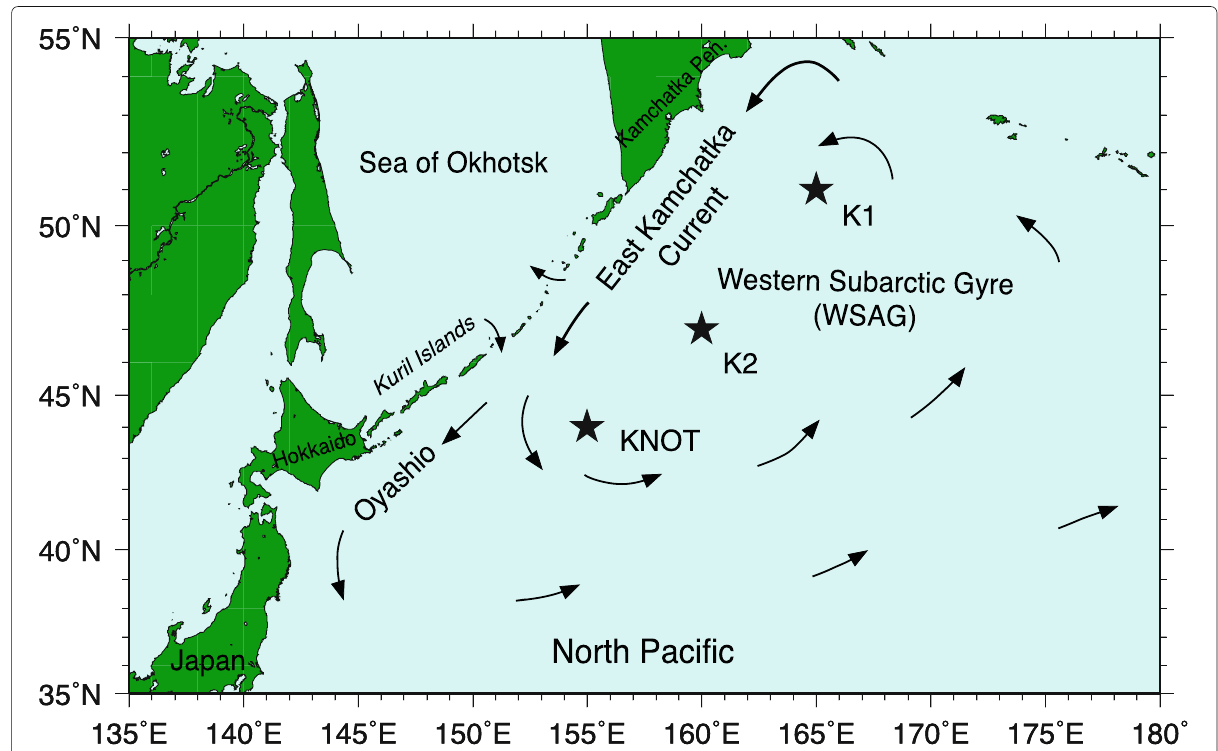
Fig. 1 Schematic diagram of the sea surface flows (arrows) in the western subarctic North Pacific. Locations of stations K1, K2, and KNOT are indicated by